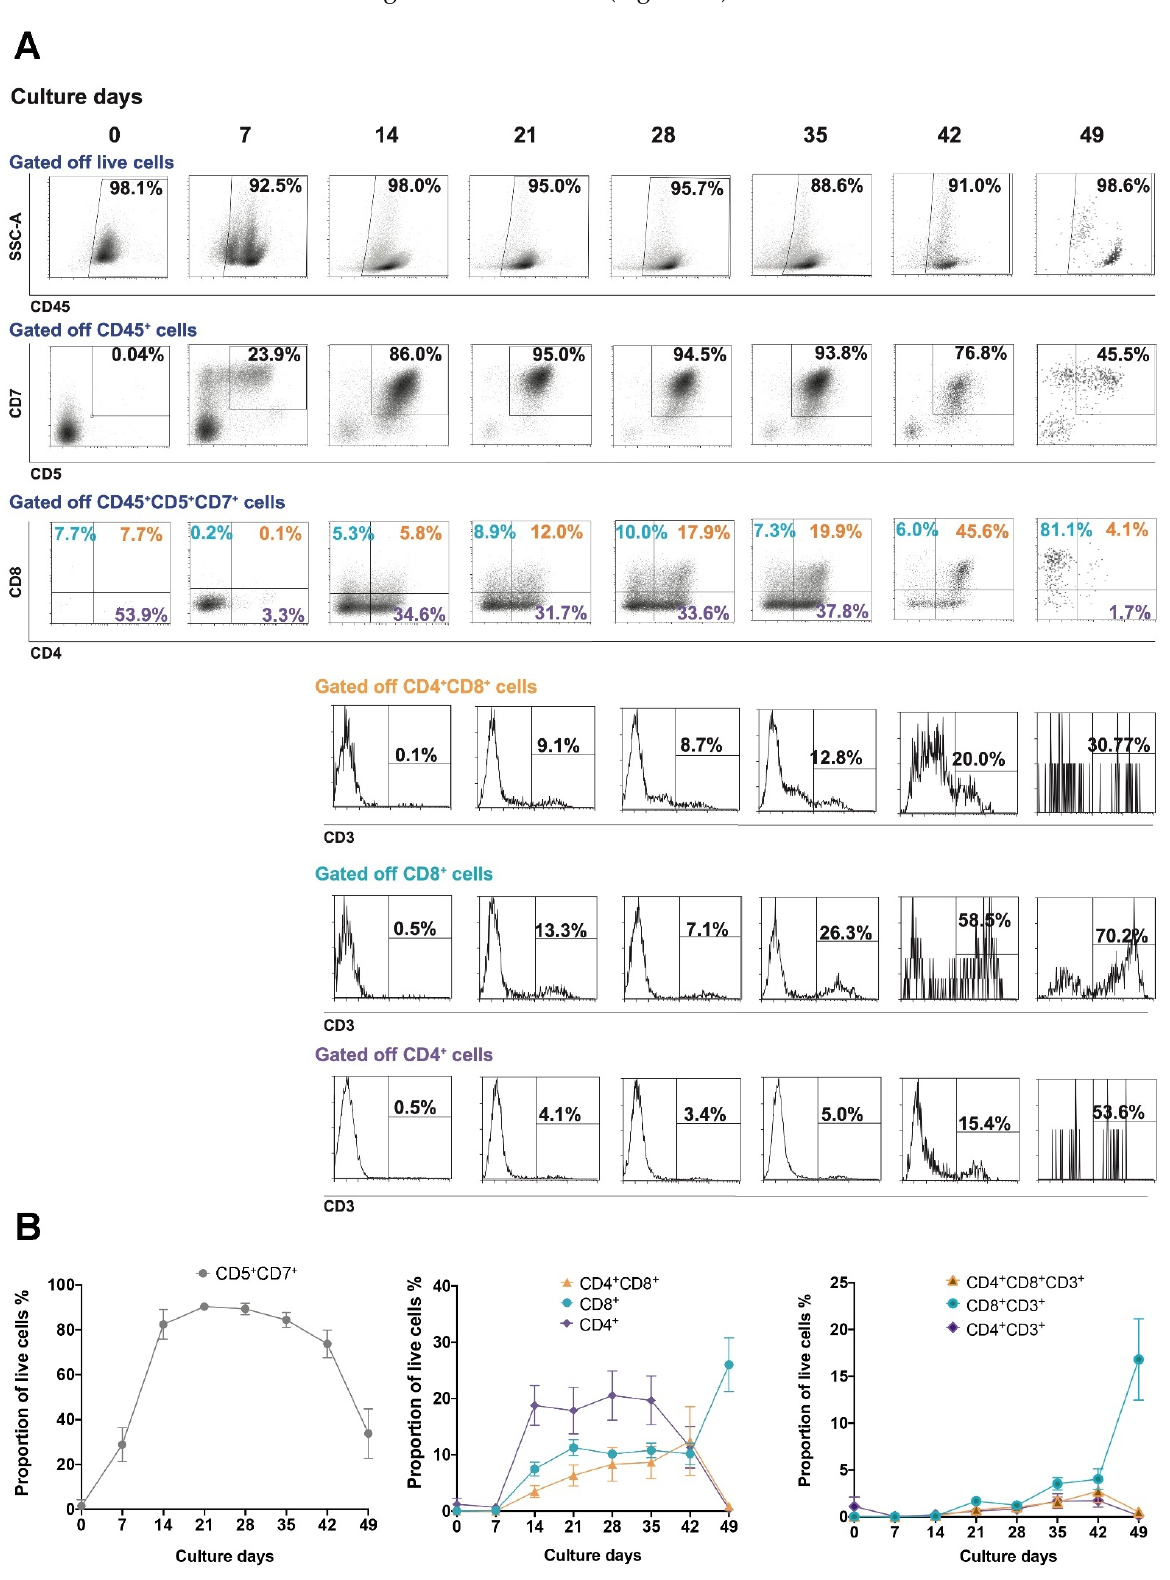
Figure 3. HSC-derived T cell phenotype development resembles endogenous T cell phenotype development. ( A ) Pro-T